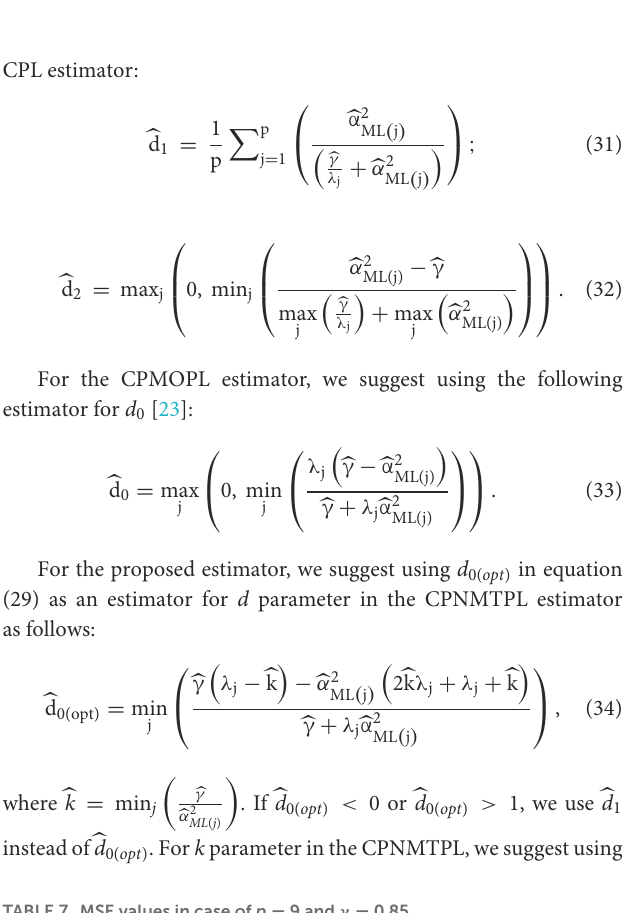
TABLE 7 MSE values in case of p = 9 and γ =